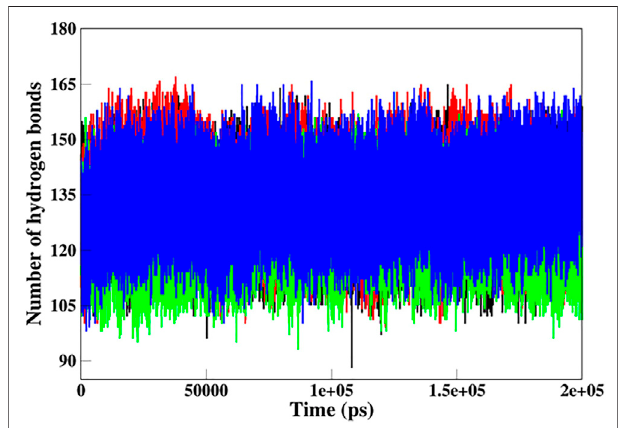
FIGURE 8 | Secondary structural contents of SGK1 WT; T256A; K127M; and Y298A mutants.